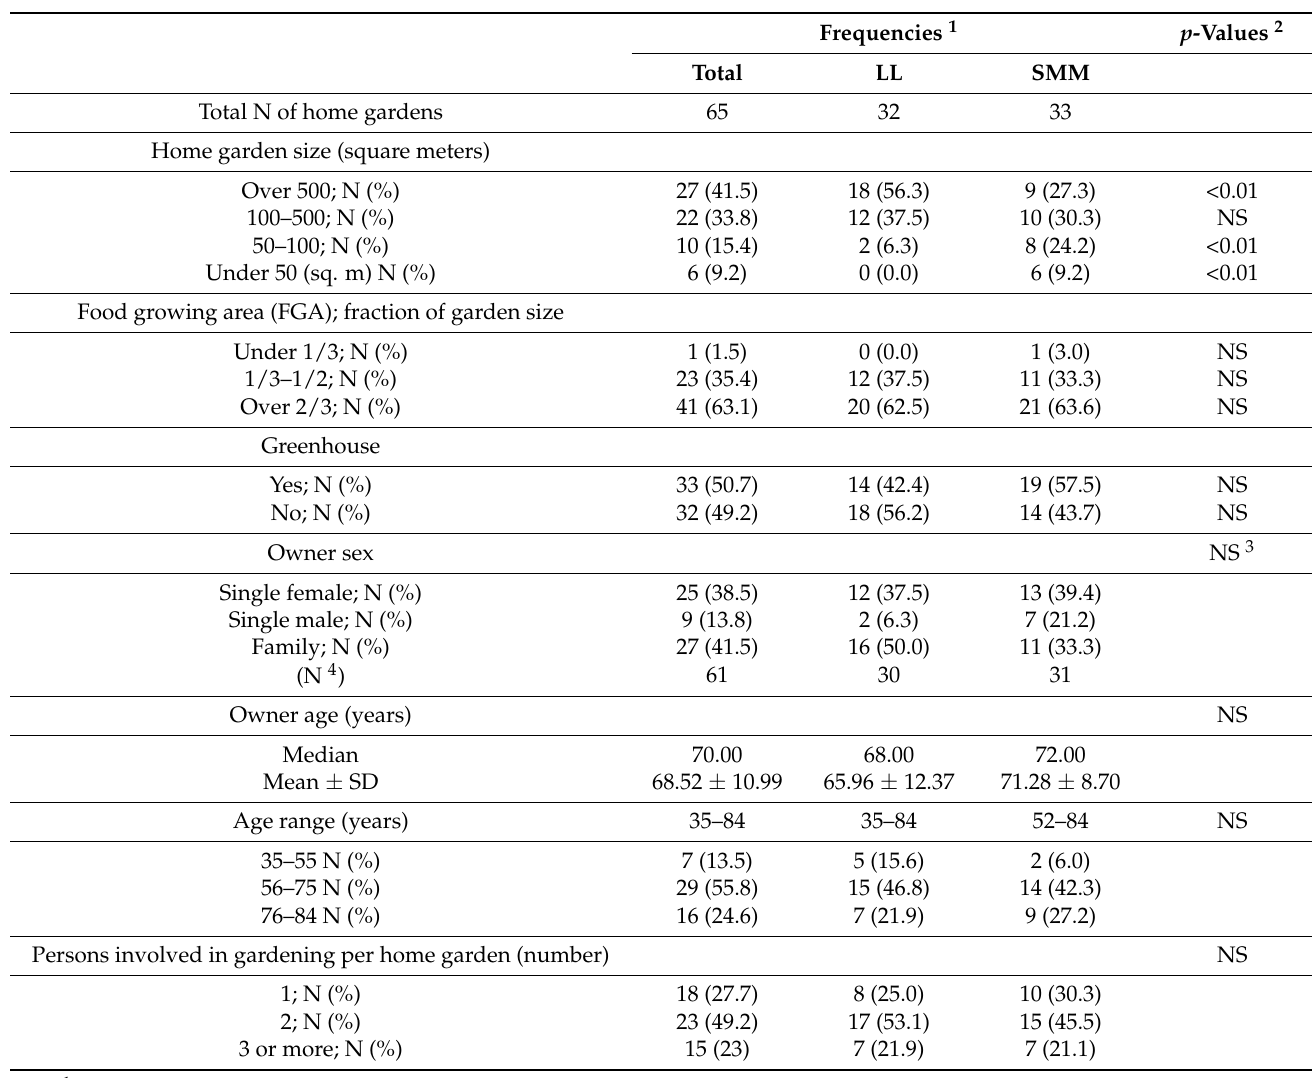
Table 1. Characteristics of the studied home gardens and owners. Frequencies 1 p -Values